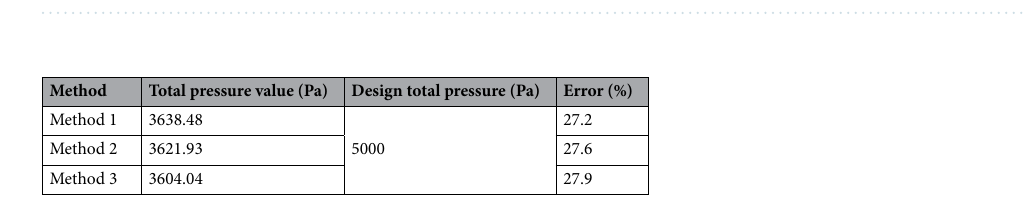
Table 5. Comparison of simulation results and experimental results.